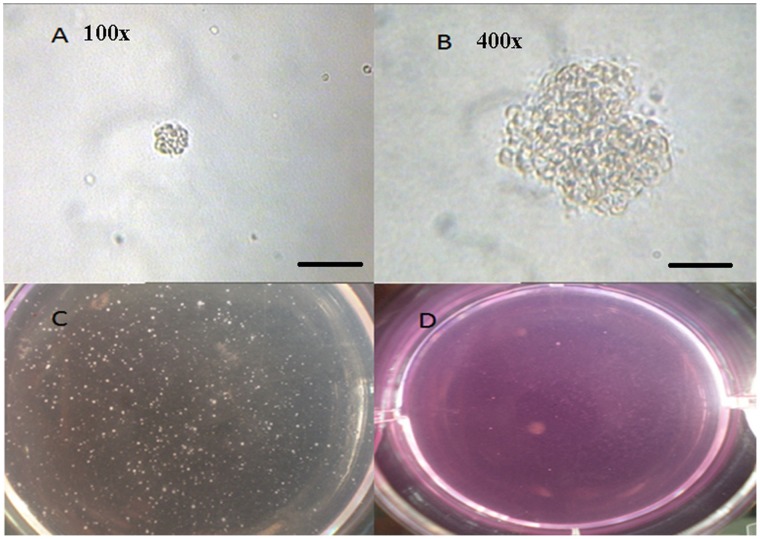
Representatives of colony in soft agar.(A) A colony in soft agar, scale bar = 10 µm; (B) A colony in soft agar, scale bar = 50 µm; (C) The representative of colonies of BEAS-2B cells in Co-culture/CTPE group at passage 20 in dish; (D) The representative of colonies of BEAS-2B cells treated with DMSO at passage 20 in dish.